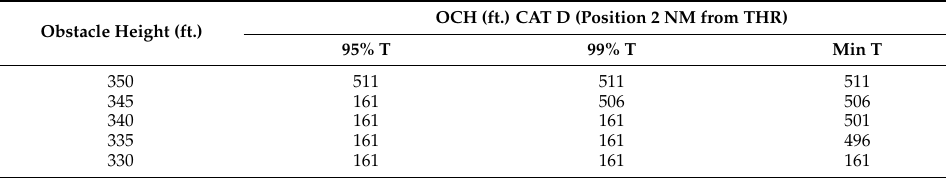
Table 10. OCH obstacles in the same position but at different